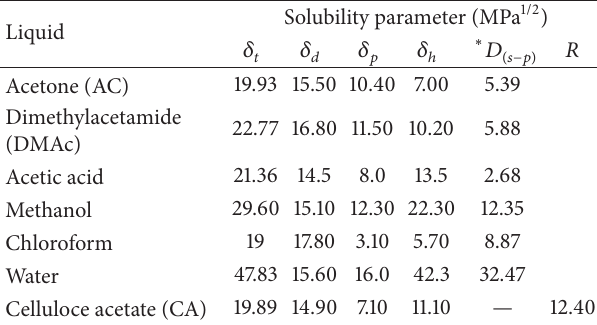
Table 2: Total solubility parameters ( 𝛿 𝑡 ) of various solvents and cellulose acetate [14,